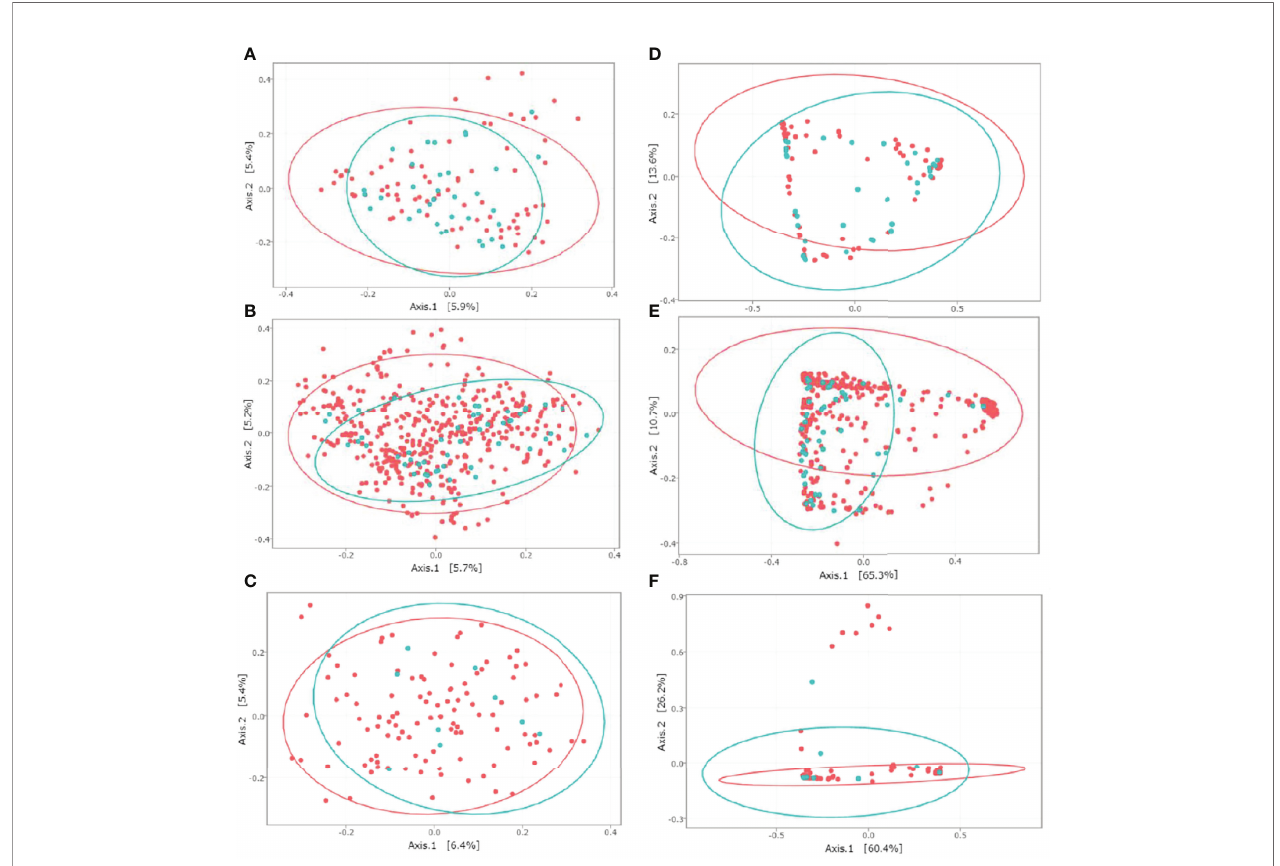
FIGURE 2 | MDS representation of the intestinal microbiota based on Jaccard and wUnifrac indices for ClosNEC [ (A) and (D) ], EPIFLORE_D28 [ (B) and (E) ] and EPIFLORE_D7_2 [ (C) and (F) ], respectively. Each sample is represented by a color according to its category: red, CD − (ClosNEC, EPIFLORE_D28) or CD − D28 (EPIFLORE_D7_2); blue, CD+ (ClosNEC, EPIFLORE_D28) or CD+D28 (EPIFLORE_D7_2). The percentage of variation explained by the two fi rst MDS dimensions is indicated on the respective